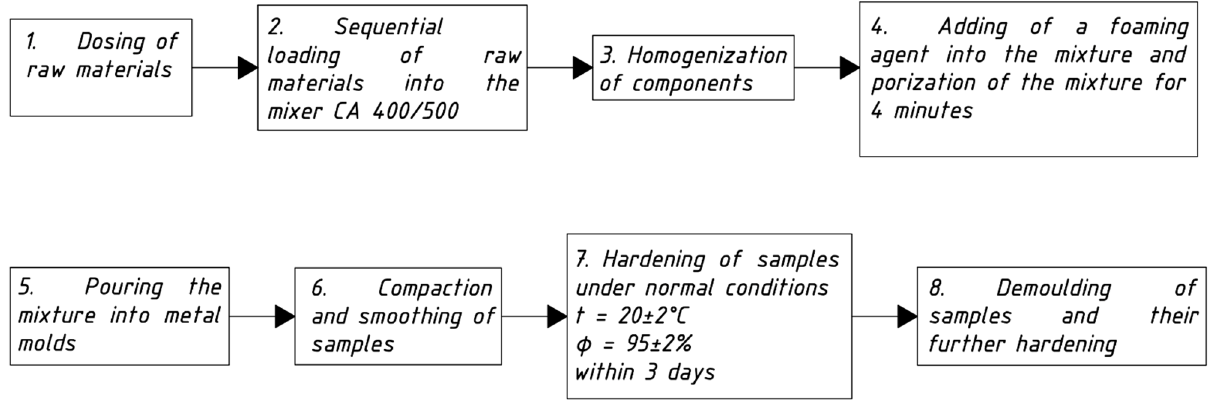
Figure 2. The process of manufacturing experimental samples.